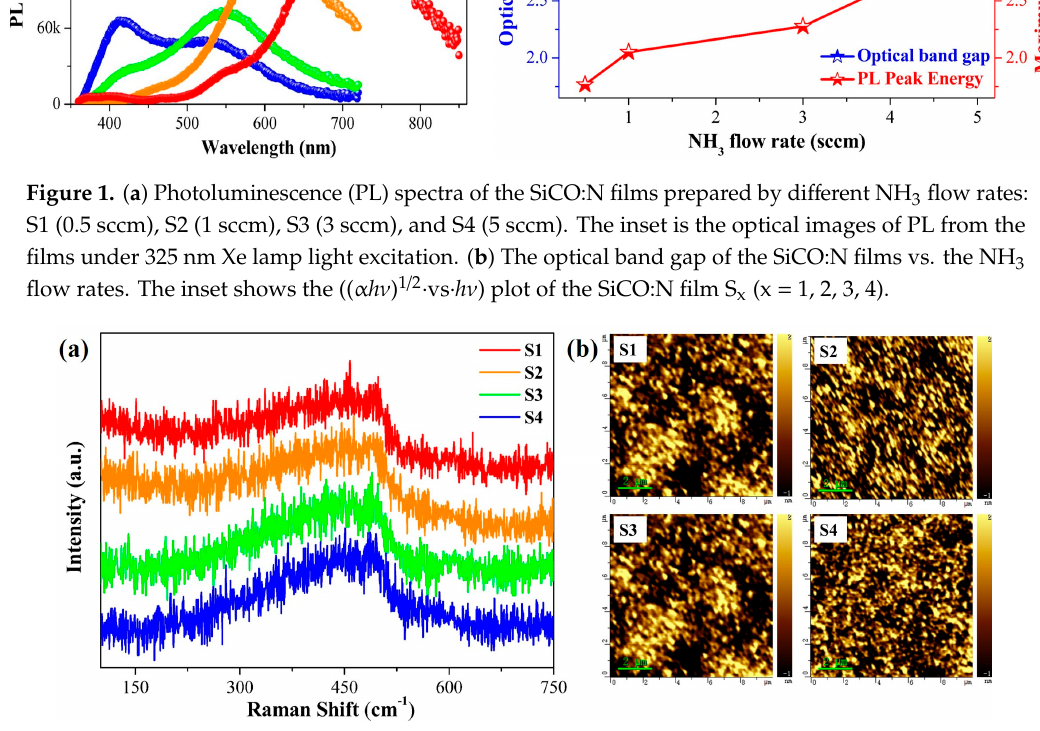
Figure 2. ( a ) Raman spectra of the SiCO:N films with various NH 3 flow rates, ( b ) atomic force microscopic images of the SiCO:N films prepared by different NH 3 flow rates: S1 (0.5 sccm), S2 (1 sccm), S3 (3 sccm), and S4 (5 sccm).